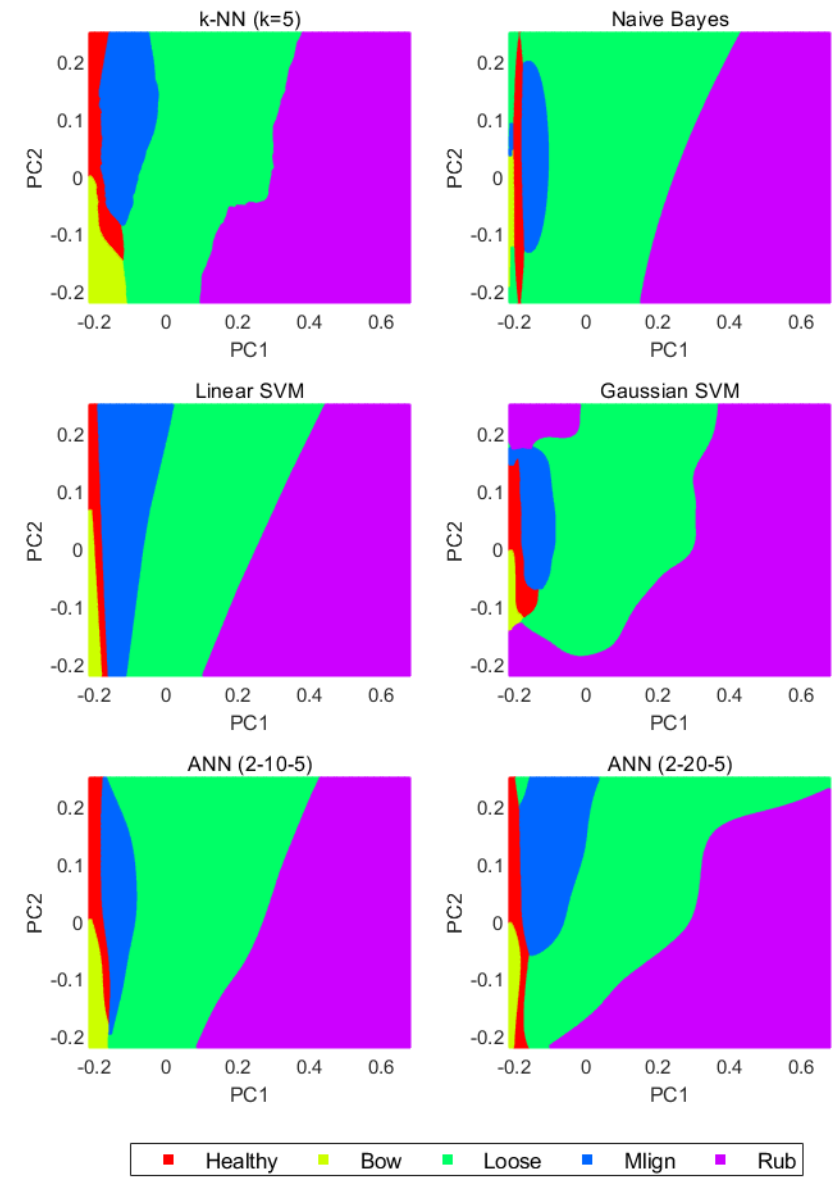
Figure 7. Visualised decision rules for the centralised ratio at 20 Hz.